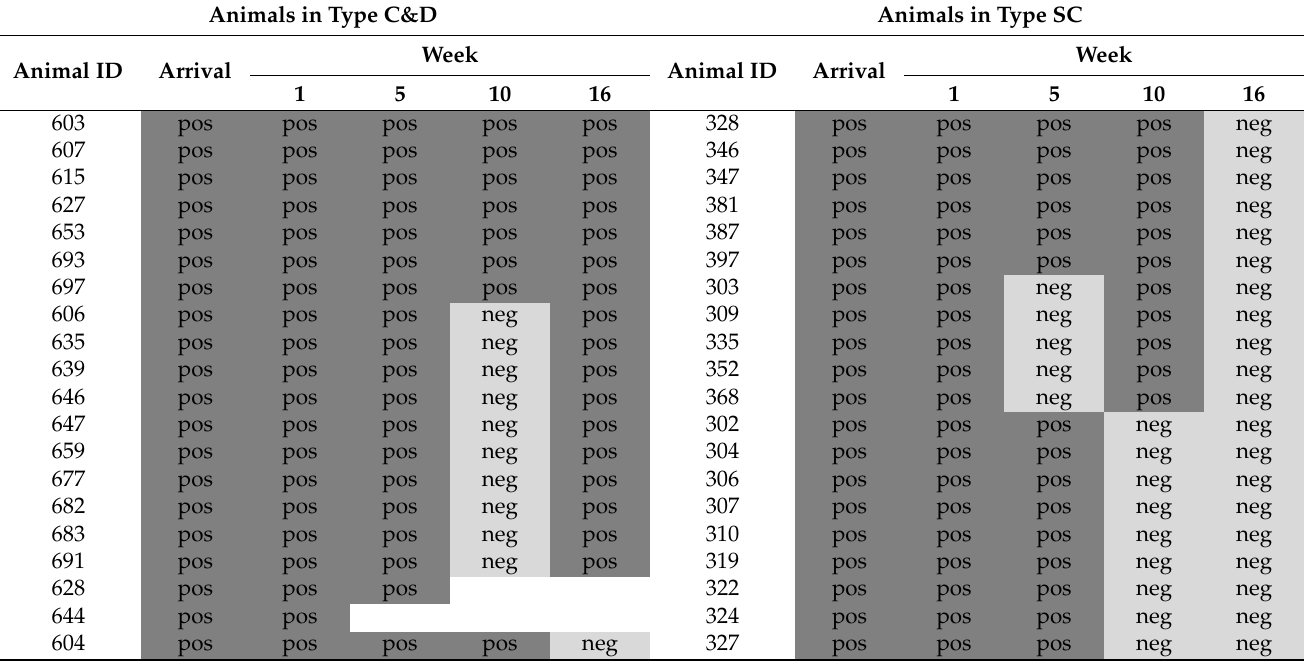
Table 1. Individual animal tracking and LA-MRSA status from arrival to week 16 of fattening phase (pos = positive; neg = negative). Animals in Type C&D